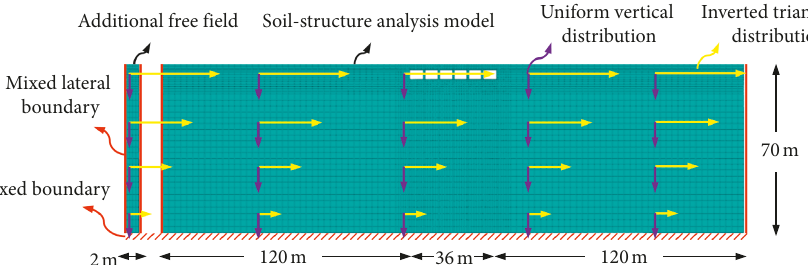
Figure 5: Soil-underground structure pushover analysis model with the additional free field.